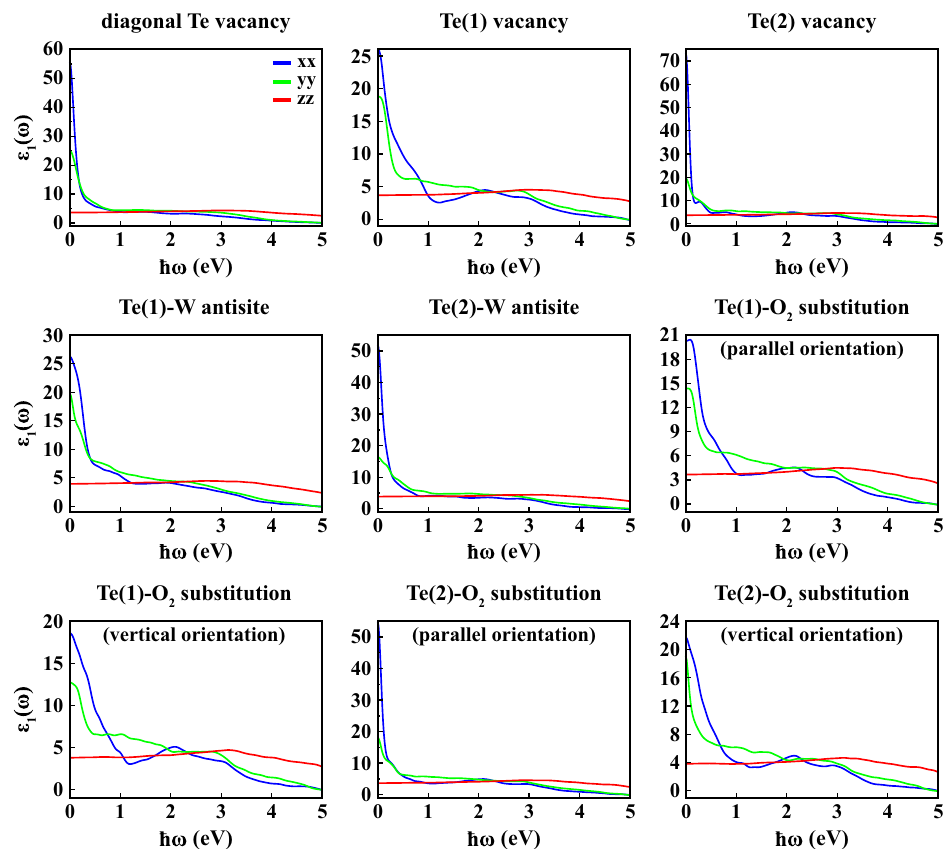
Figure 8. Real part of frequency dependent dielectric constant ( ε 1 (ω) ) as a function of photon energy ( (cid:31) ω ) calculated within PBE+SOC at 0 K along crystallographic axes ( xx , yy , zz ) for 1L defective 1T ′ WTe 2